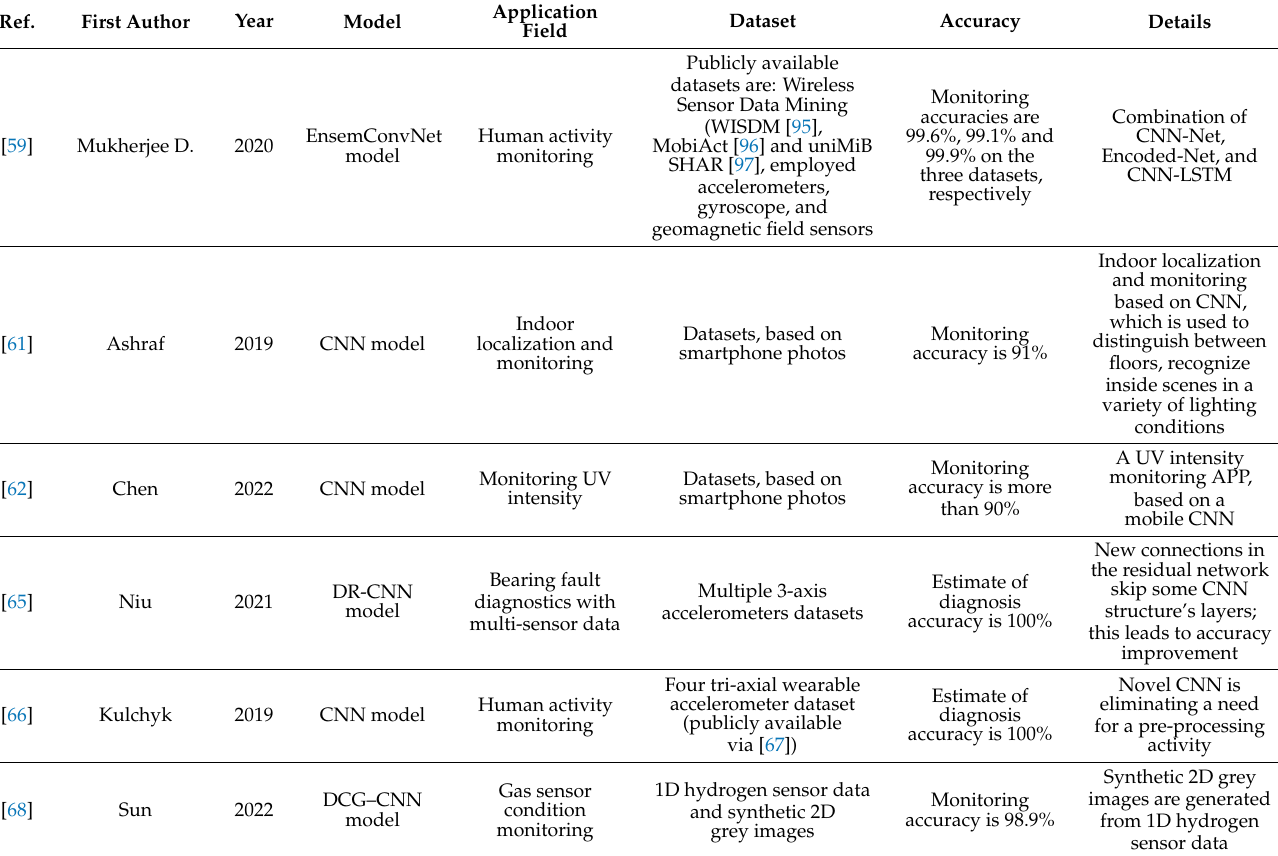
Table 3. Summary of the deep learning advances for sensing and condition